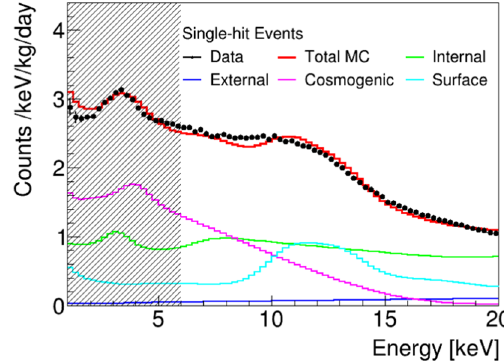
contributions in the energy region of (2–6) keV. As we low- ered the threshold to 1 keV, the background modeling was carriedout accordingly. Themodel includes backgroundcon- tributions from both internal and external sources, including cosmogenic radionuclides and surface 210 Pb contamination.